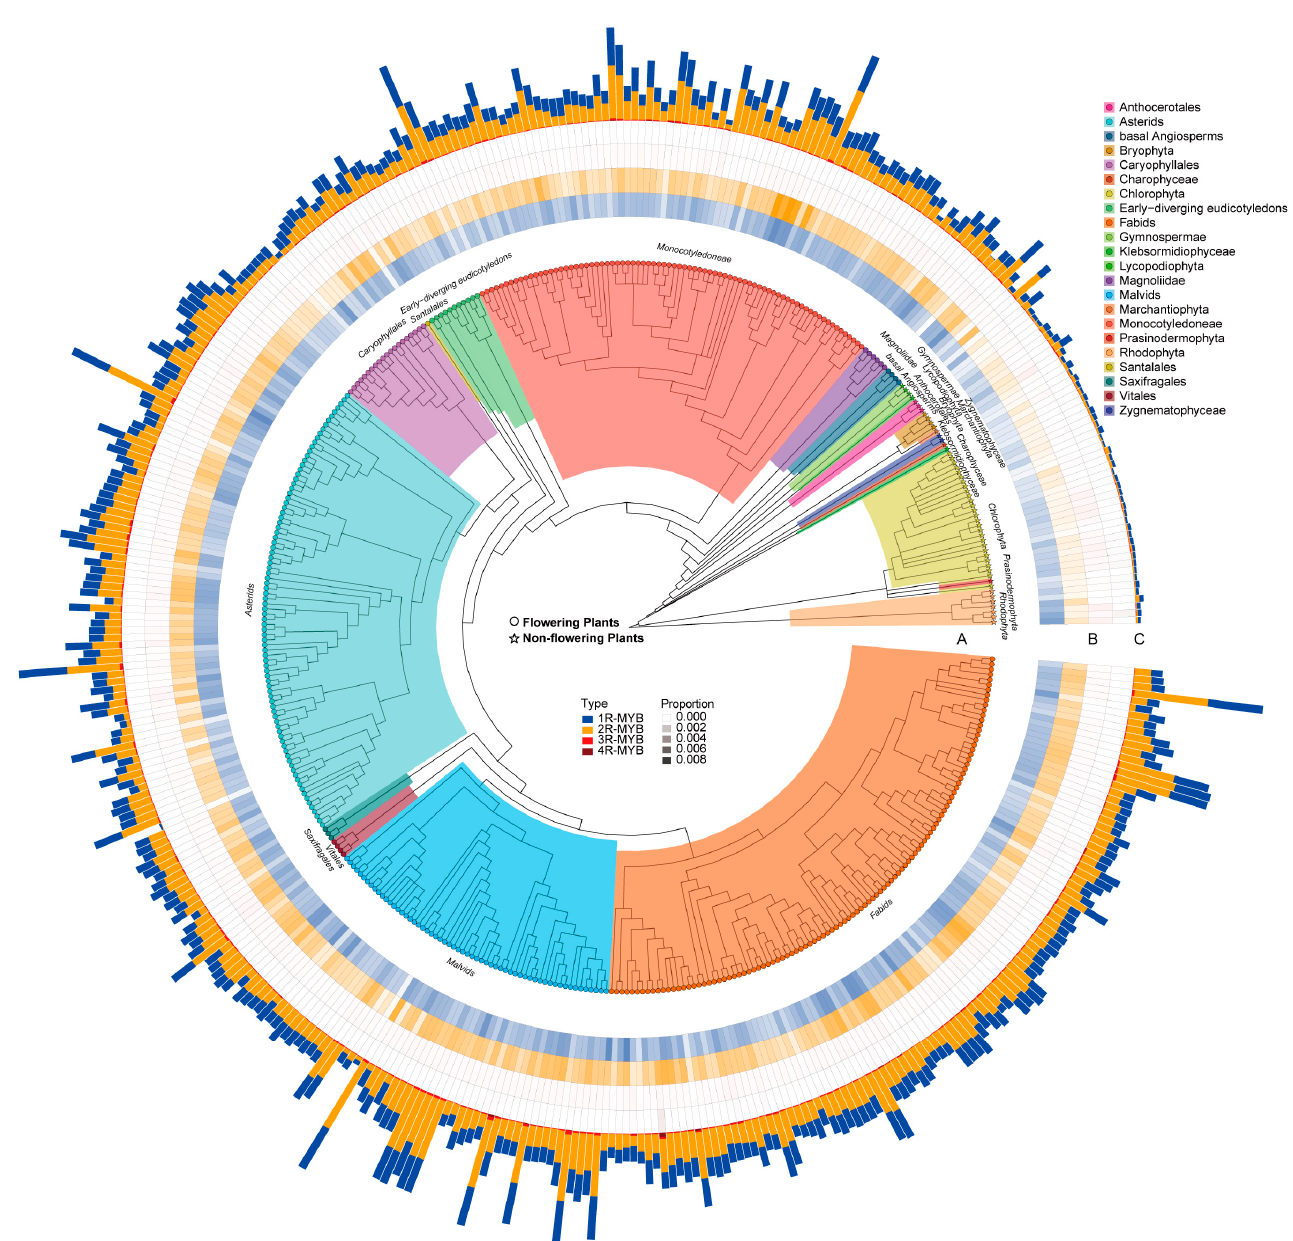
Figure 2. Number of MYB family members in the 437 plant genomes. ( A ) The phylogenetic tree of the 437 plant species. The tree was colored based on the information of the defined 22 categories, and the color corresponding to each category was shown on top right. Colored circle (for flowering plants) or star (for non-flowering plants) on the tip of each branch represents a species. ( B ) The four tracks next to the phylogeny show the proportion of MYB subfamily genes in the genome of each species. The tracks from inside to outside are 1R-MYB, 2R-MYB, 3R-MYB, and 4R-MYB. Each MYB subfamily (or track) was shown with a specific color. The values of percentage were divided and shown with different shade indicated in the center of the plot (dark shade means high proportion). ( C ) The outermost track shows the total number of MYB subfamily members in each genome. Blue represents 1R-MYB subfamily, orange represents 2R-MYB subfamily, red represents 3R-MYB subfamily, and dark red represents 4R-MYB subfamily. Figure was plotted using R package ‘ggtree’ (https://bioconductor.org/packages/release/bioc/html/ggtree.html accessed on 20 May 2022).